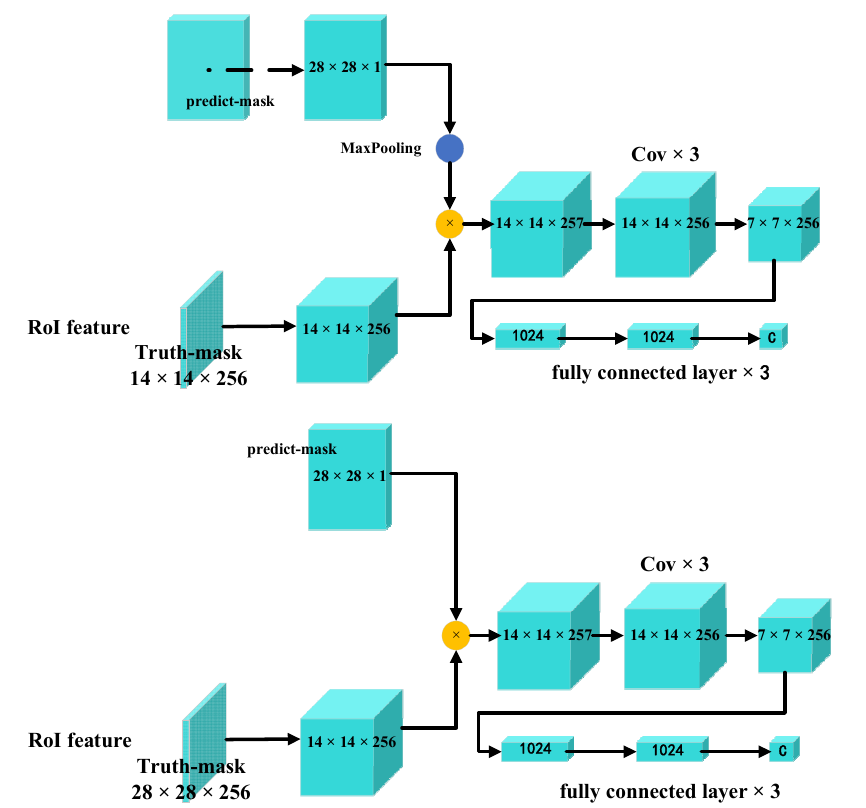
Figure 5. Two input structures of CQE head.